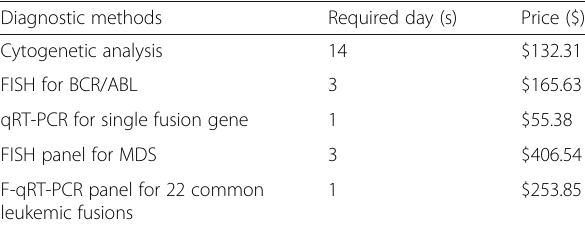
Table 7 Comparison of different diagnostic methods in Henan Cancer Hospital Diagnostic